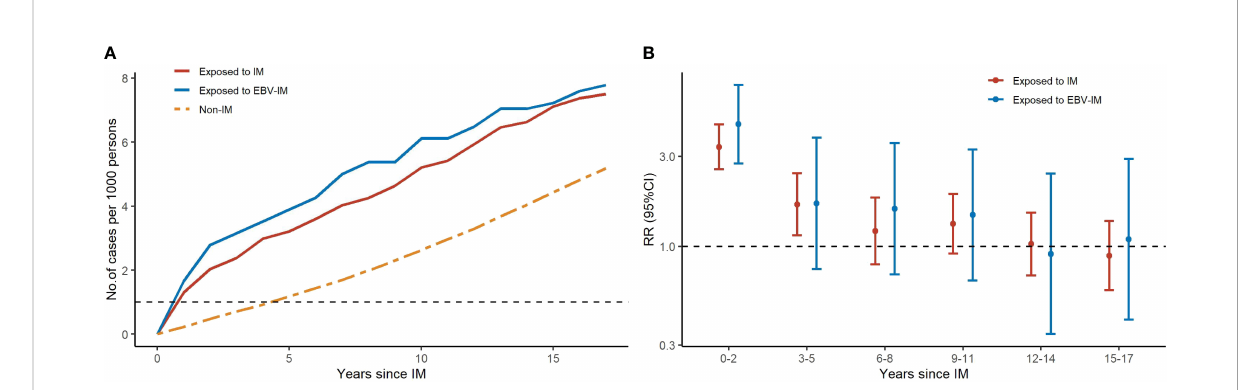
FIGURE 3 Risks of Subtypes of Malignancy According to Infectious Mononucleosis (IM) with Different Follow-up periods. Graph (A) shows the number of cases for total malignancy by years since IM for 3 groups (exposed to IM, exposed to EBV-IM and non-IM). Graph (B) shows rate ratios (RRs) with error bars representing 95% con fi dence interval (CIs) for total malignancy at different follow-up